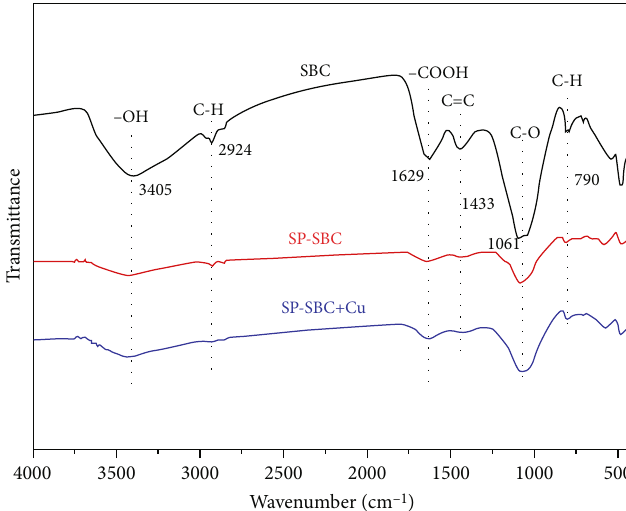
Figure 4: FTIR spectra of SBC, SP-SBC, and SP-SBC+Cu.